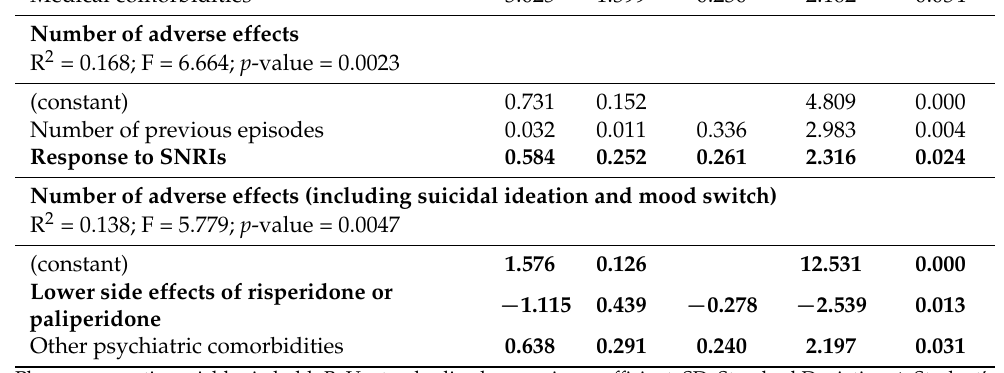
(Table 3). The genetically determined response to SNRIs—based on the analysis of the ABCB1 gene—showed a significant negative correlation with the CGI-BP-M overall score ( p -value < 0.030) and the depression subscore ( p -value < 0.026) at enrollment, indicating an association with lower scores in both domains of this scale (Table 3). The response to SNRIs was also correlated with lower scores in the HDRS-17 scale at the time of analysis, and with a higher number of adverse effects ( p -value < 0.024) (Table 3). The variable “reduced metabolism of quetiapine”—determined by the presence of CYP3A4*22 allele—was iden- tified as a significant predictor of lower scores in the overall CGI-BP-M ( p -value < 0.038) and the depression subdomain ( p -value < 0.025) at enrollment. The pharmacogenetic variable lower risk of side effects of risperidone or paliperidone—based on the analysis of an mTOR-related multigenic predictor—was negatively correlated with the number of adverse effects, when including suicidal ideation and mood switch ( p =